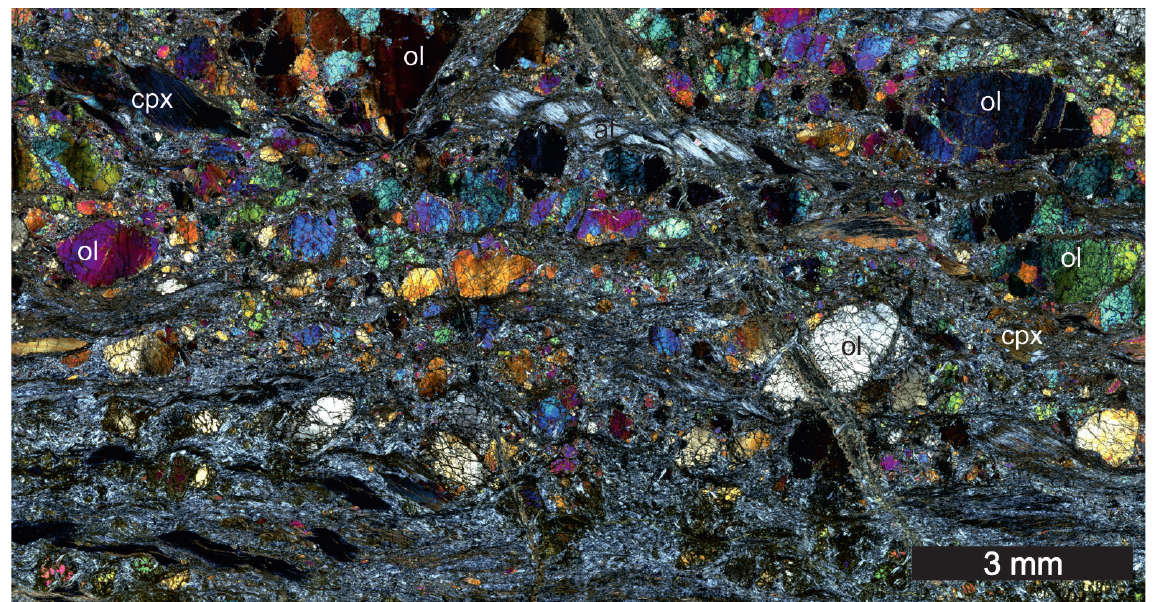
Fig. 2. Polarized light micrograph (crossed polarizers) of a typical sample of investigated partly serpentinized peridotite mylonites. Olivine and clinopyroxene porphyroclasts are embedded in an antigorite-rich matrix (sample